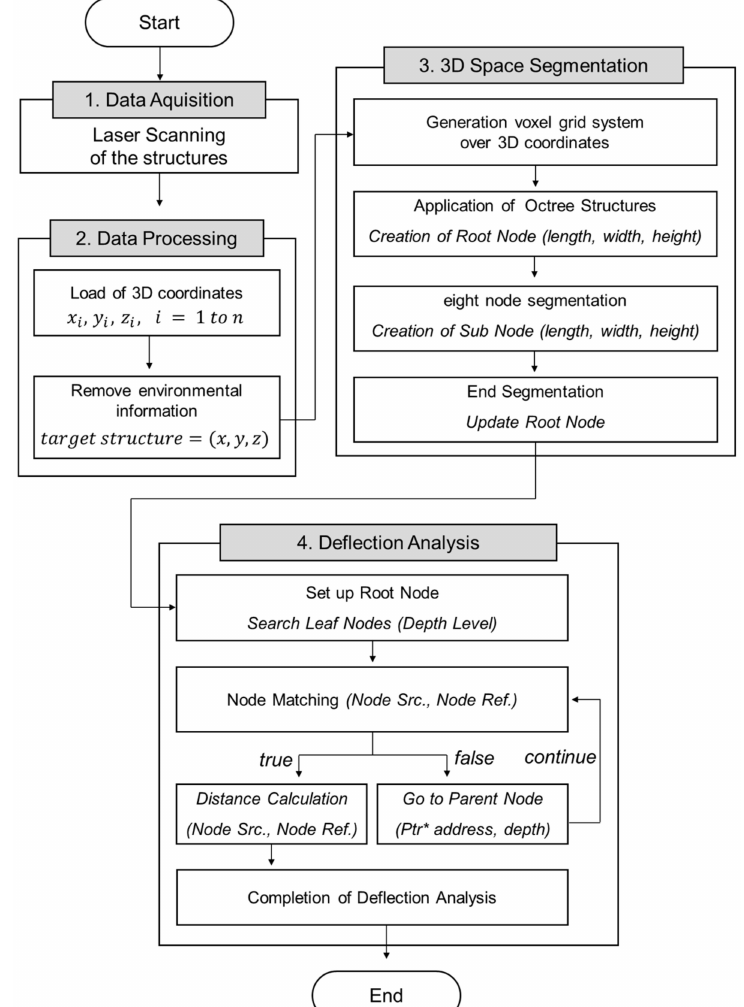
Figure 2. Vertical displacement estimation process using 3D spatial